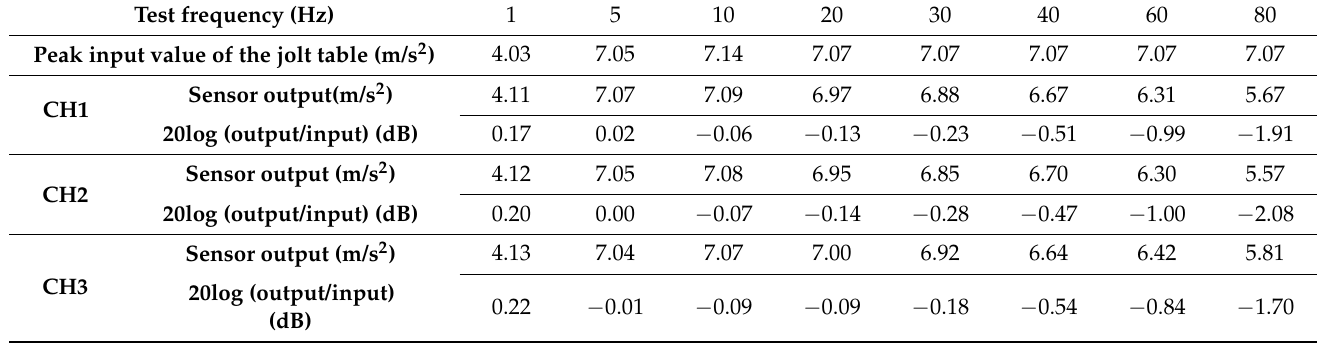
Table 1. Amplitude–frequency data from our instrument recorded during a session on a jolt table (sampling rate: 200 SPS).